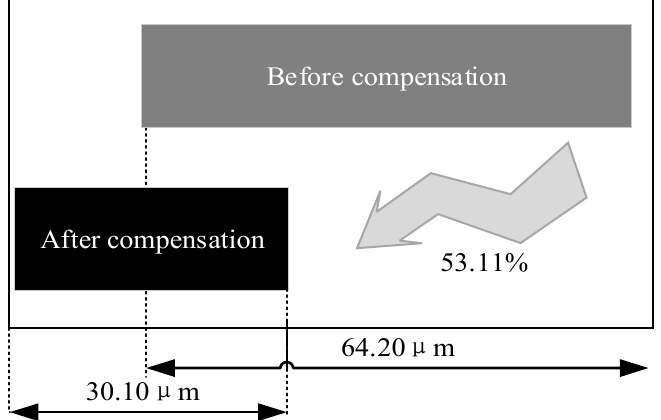
Figure 22. Comparison of the compensation before and after the feed axis.